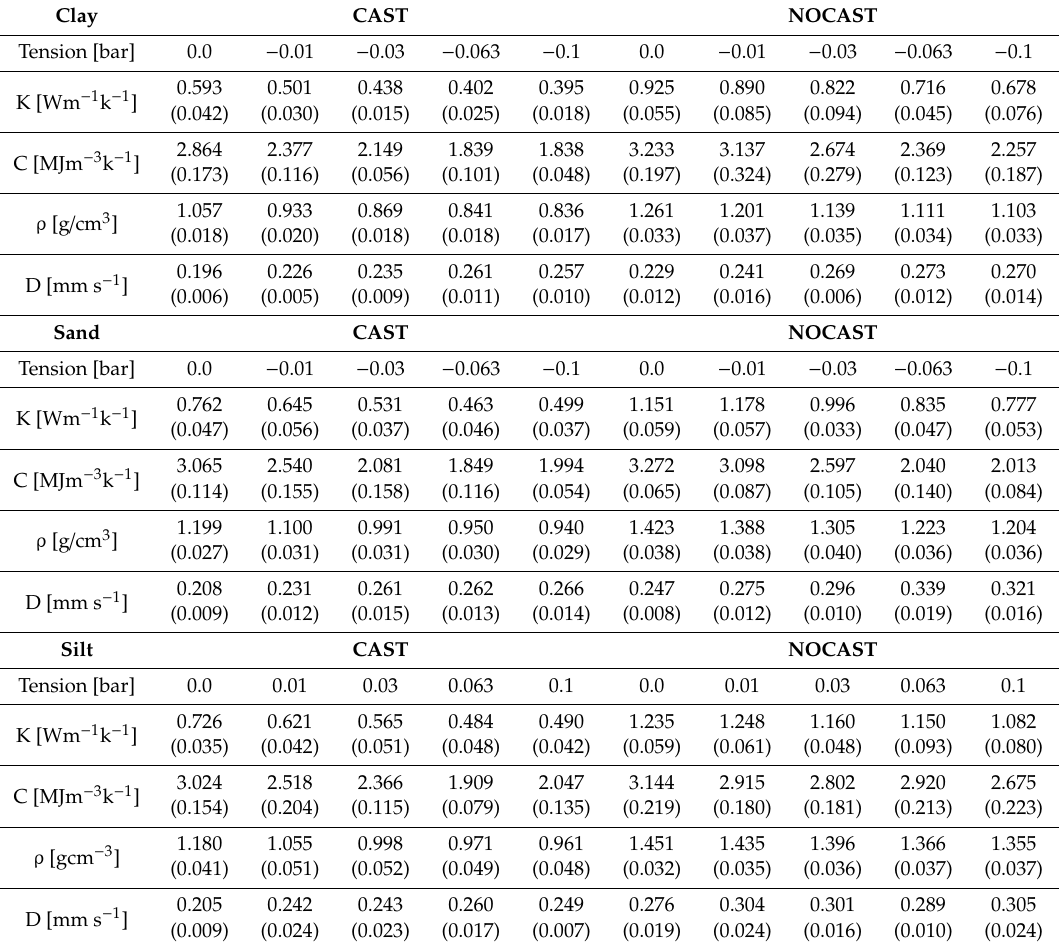
Table A2. Dependence of mean (1 standard error) heat capacity, C, thermal conductivity, K, density (including soil moisture), ρ , and thermal di ff usivity, D on soil tension (from saturation to 0.1 bar) for Amynthas cast and unaltered soil material for three soils with di ff erent textures. Replication rate = 6 per